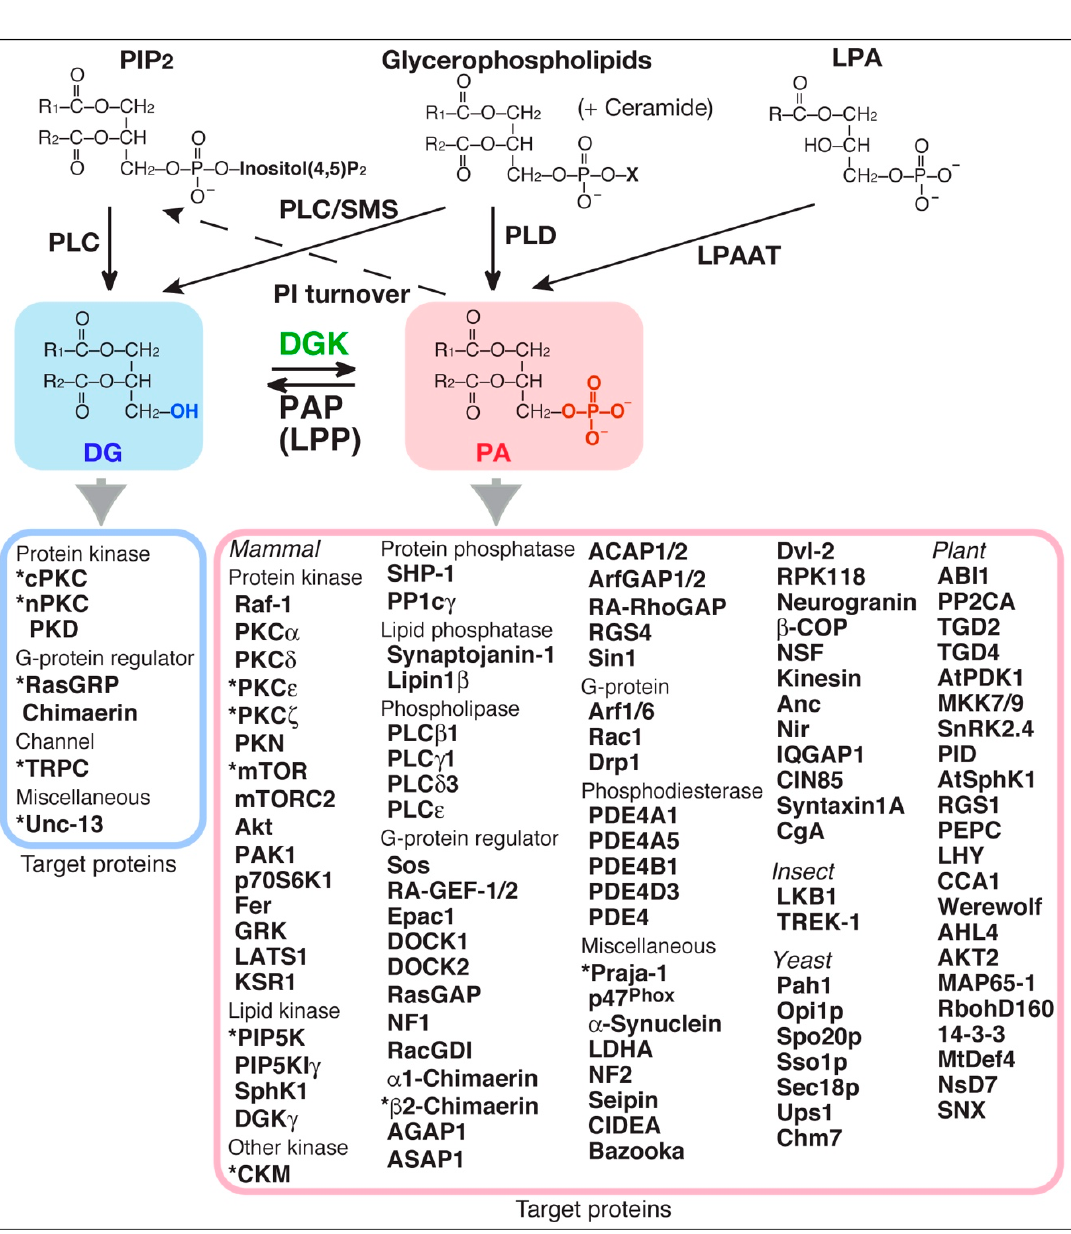
Figure 1. Target proteins of substrate (DG) and reaction product (PA) of DGK. Asterisks indicate target proteins that have been strongly suggested to be regulated by DGK isoforms through consumption of DG or production of PA. PAP, PA phosphatase; LPP, lipid phosphate phosphatase; PC, phosphatidylcholine; PI, phosphatidylinositol; PIP 2 , PI 4,5-bisphosphate; PLC, phospholipase C; PLD, phospholipase D; cPKC, conventional protein kinase C (PKC α , β and γ ); nPKC, novel PKC (PKC δ , ε , η and θ ); PKD, protein kinase D; Unc-13, uncoordinated-13; RasGRP, Ras guanyl nucleotide-releasing protein; TRPC, transient receptor potential channel; chimaerin (RacGAP); Raf-1 / C-Raf, rapidly accelerated fibrosarcoma (serine / threonine protein kinase); PKC ζ (atypical PKC (aPKC)); PKN (aPKC); mTOR, mammalian target of rapamycin (serine / threonine protein kinase); mTORC2, mTOR complex 2; Akt / protein kinase B; PAK1, p21-activated kinase 1; p70S6K1 / S6K1, ribosomal protein S6 kinase β -1; Fer (tyrosine protein kinase); GRK, G protein-coupled receptor kinase; LATS1, large tumor suppressor kinase 1; KSR1, kinase suppressor of Ras 1 (serine / threonine protein kinase / sca ff old protein); PIP5K, PI-4-phosphate 5-kinase; SphK1, sphingosine kinase 1; CKM, creatine kinase-muscle type; SHP-1, Src homology